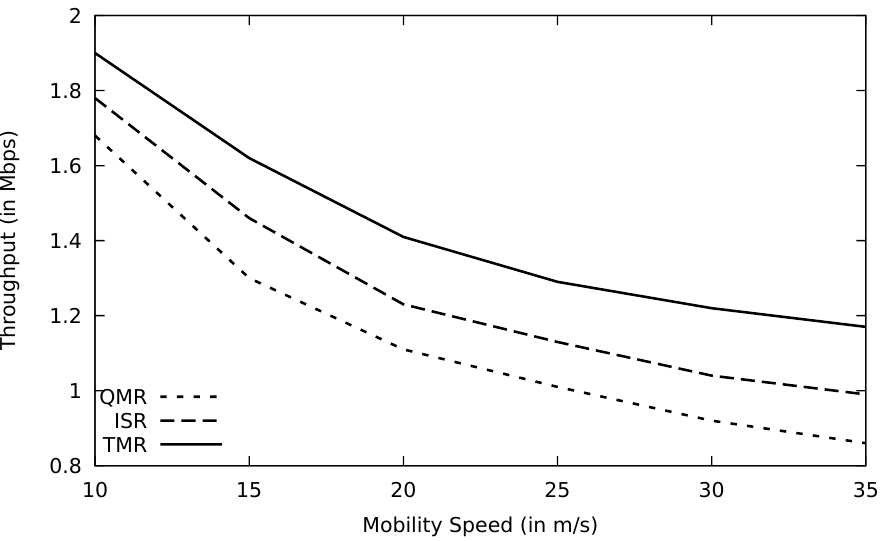
Figure 28. Comparison of QMR, ISR, and proposed protocol TMR for throughput with mobility speed.